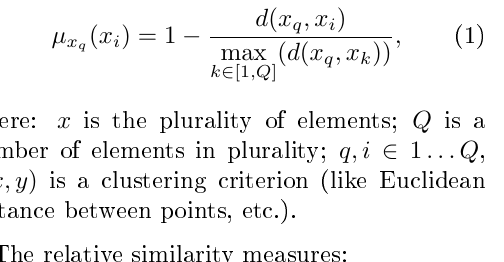
Fig. 1: "A Quasi-Equivalence" clustering (cid:29)ow-chart.